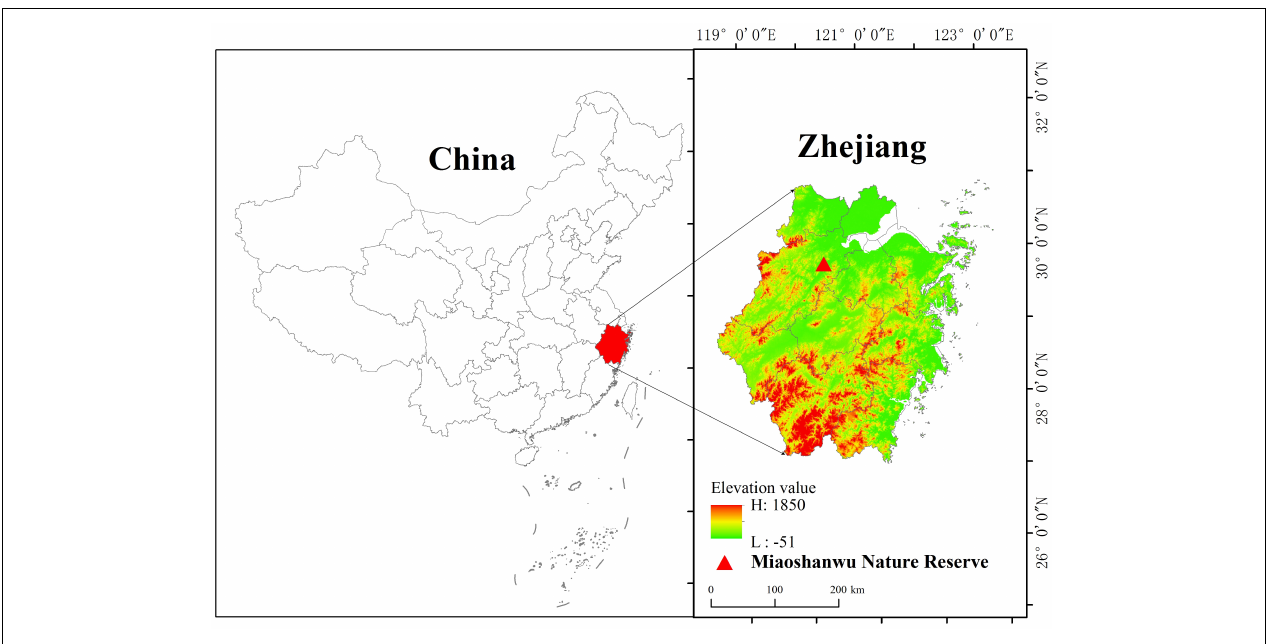
FIGURE 1 | Location of the experimental forest, Miaoshanwu Nature Reserve, Zhejiang province, China. TABLE 1 | Physicochemical properties (mean ± standard error; n = 3) of the sites where the litter decomposition experiment was conducted. Rapidly available P (mg/kg) Rapidly available K